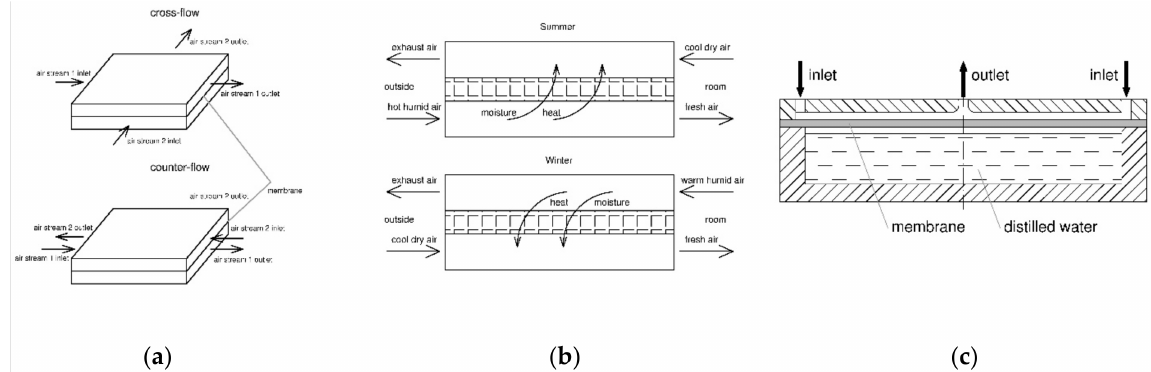
Figure 10. The heat exchangers with membrane: ( a ) solid membrane [107], ( b ) thin membrane to heat and moisture transfer [108], ( c ) liquid membrane